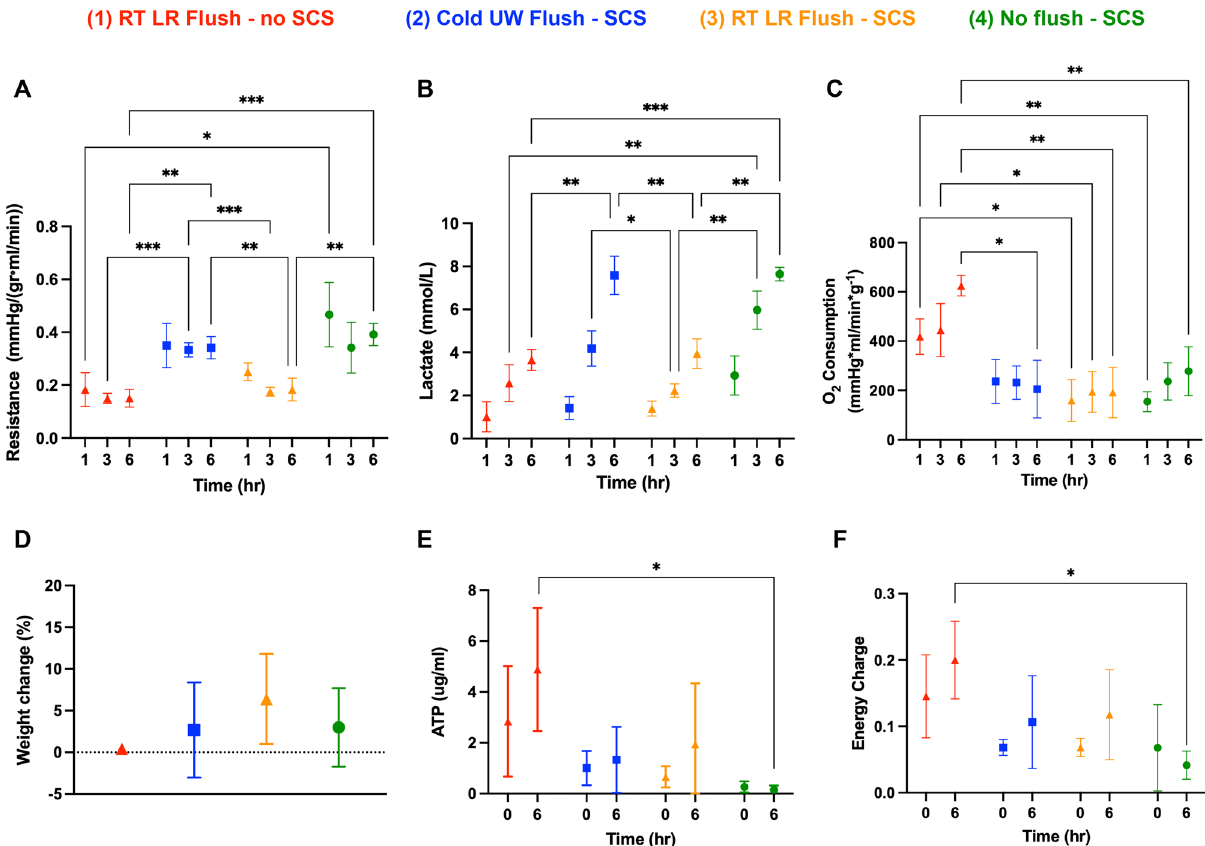
Figure 2. Perfusion metrics of 6 h ex-vivo rat liver NMP detailing ( A ) R, intrahepatic resistance, ( B ) lactate, ( C ) oxygen consumption, ( D ) percent liver weight change, ( E ) ATP, and ( F ) energy charge. RT LR flush livers with no SCS (red, n = 4) had the lowest resistance, the lowest lactate levels, and the highest oxygen consumption while no flush livers with SCS (green, n = 4) had the highest resistance and lactate levels. Compared to the cold UW flush livers with SCS (blue, n = 4), RT LR flush livers with SCS (orange, n = 4) had significantly higher lower resistance and lactate levels at 6 h of NMP. RT LR flush livers (red) had significantly higher ATP and EC compared to no flush livers (green) at 6 h of NMP. Stars denote statistical significance (ANOVA, followed by Tukey’s post-hoc test): *0.01 < p < 0.05; **0.001 < p < 0.01; ***0.0001 < p 0.001. Icons represent means and error bars represent standard